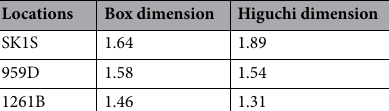
Table 5. Estimated fractal dimensions of thorium–uranium distribution in the studied OAE3 intervals.